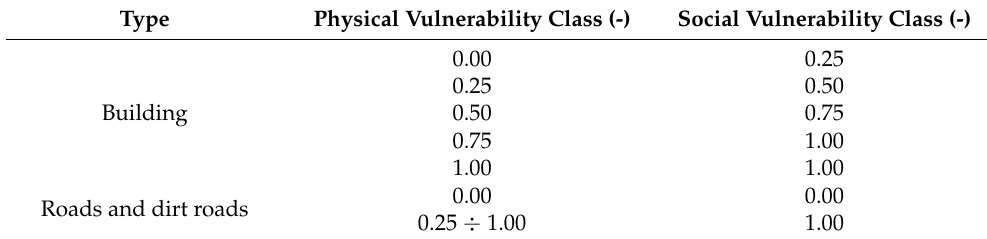
Table 6. Social vulnerability